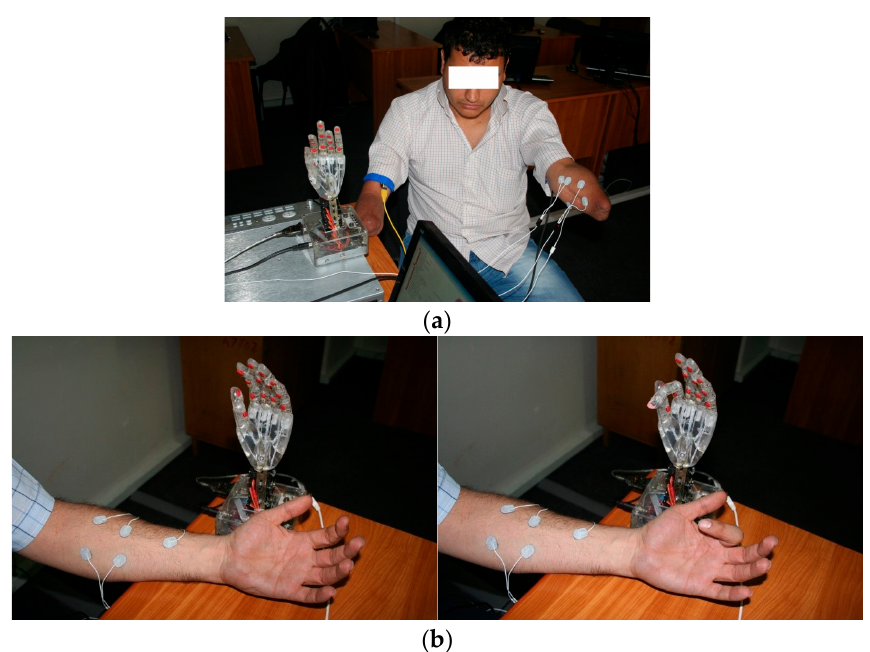
Figure 3. Patient training directly with the experimental exoprosthesis: ( a ) Double-amputated subject during preliminary training using direct connection with experimental exoprosthesis; ( b ) Bionic hand exoprosthesis used by an indemnified subject, in static position and during active